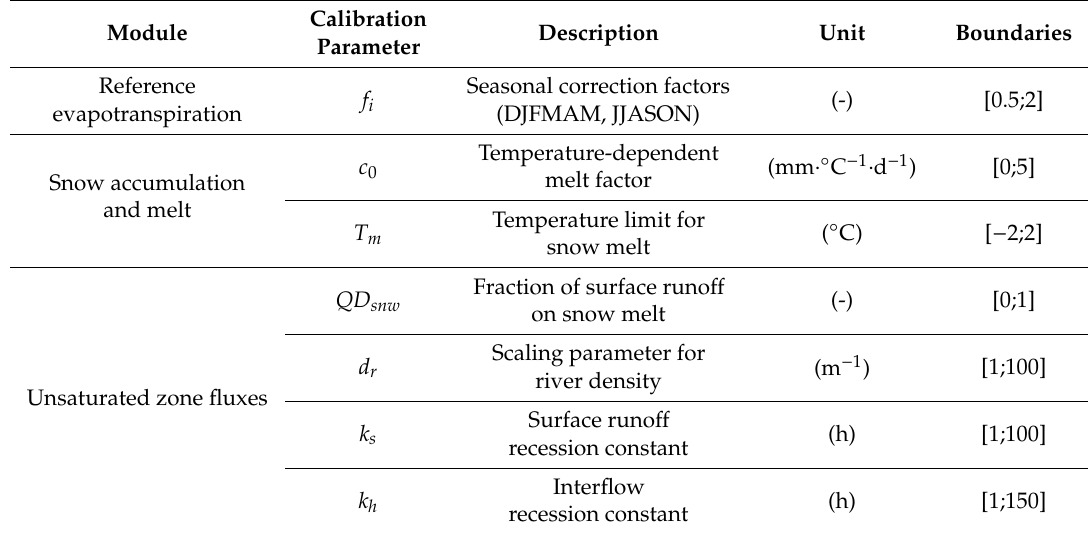
Table 2. Calibration